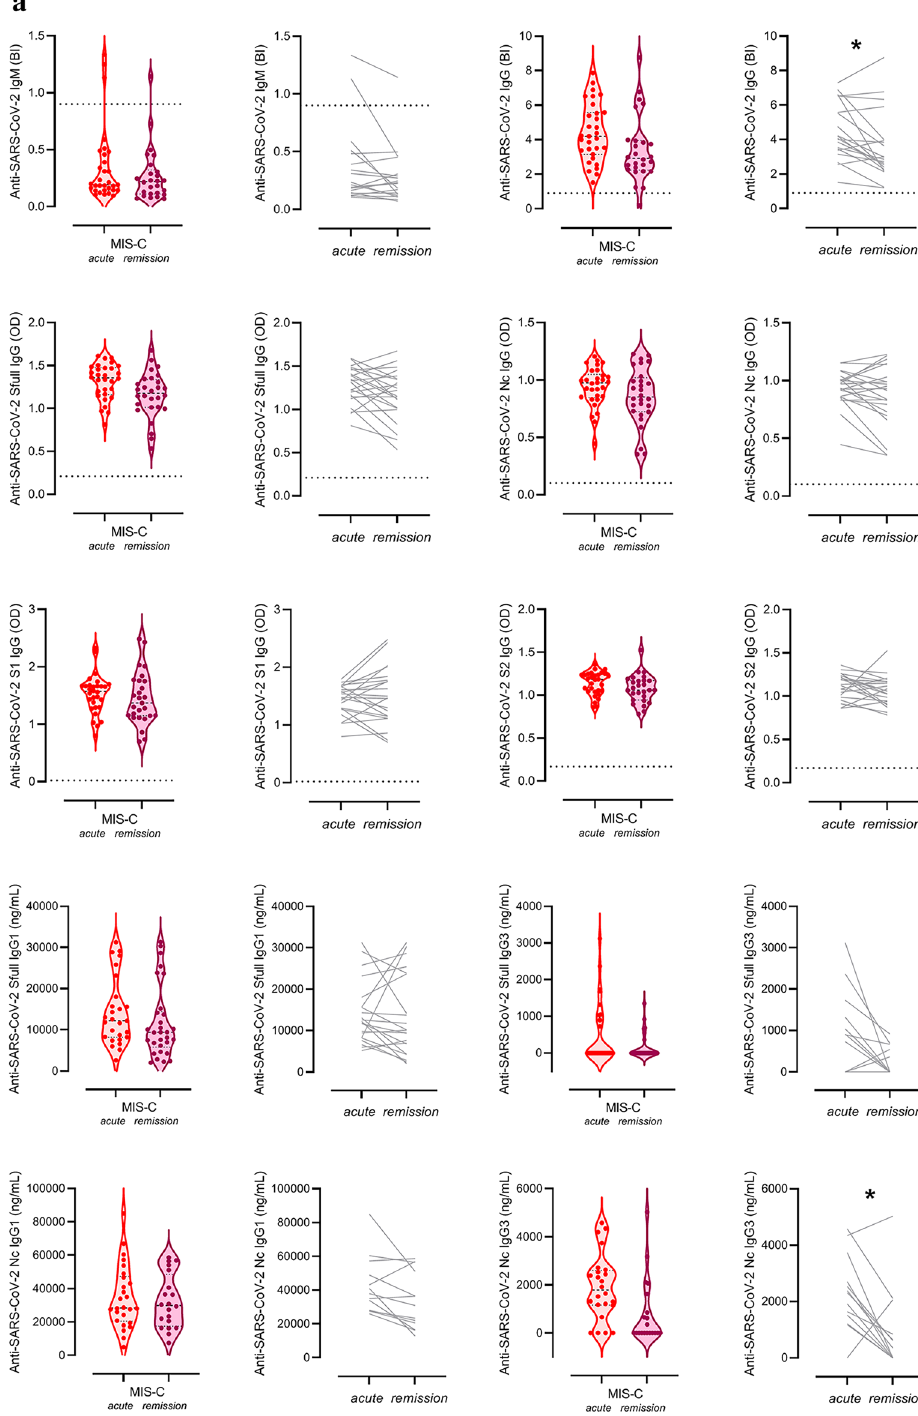
Figure 5. Association between biochemical markers of complement and anti-SARS-CoV2 antibody response, macrophage activation, acute phase reaction and clinical severity of MIS-C. ( a ) : Violin plots (with horizontal lines indicating the median values) show results for the MIS-C cases that had samples from acute stage, before IVIG treatment, or from stable remission after hospital discharge. Grey lines show changes of marker levels for individual MIS-C cases from before treatment ( ’acute ’) after hospital discharge in remission (’ remission "). P values for the line charts were obtained by the Wilcoxon matched-pairs ranked sum test. Non-significant differences are not marked, and p value symbols (* p < 0.05, ** p < 0.01, *** p < 0.001) indicate significant results after 5% false discovery rate correction using the Benjamini–Hochberg method. ( b ): Violin plots showing classical- (C1s-C1-inhibitor complex), alternative- (Bb fragment) and terminal pathway (sC5b-9 complex) activation marker levels in groups with low (below median) or high (above median) anti-SARS-CoV-2 spike and nucleocapsid IgG levels (Generic assay IgG binding index), macrophage activation (ferritin levels) or acute phase reaction (CRP concentration). * indicates p = 0.002, considered significant after 5% false discovery rate correction using the Benjamini–Hochberg